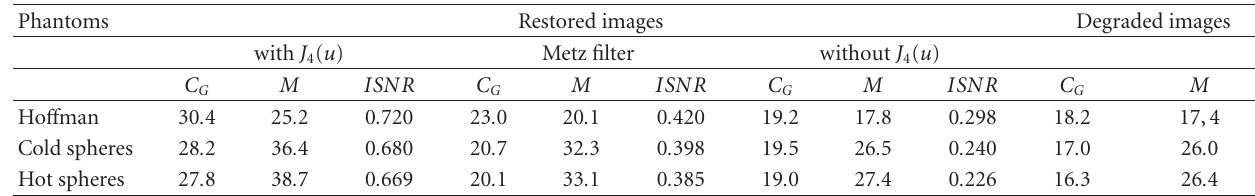
Table 1: The global contrast C G and the mottle M (expressed in %) and the improvement signal-to-noise ratio ISNR (expressed in dB) obtained from, respectively, the restored image with and without J 4 ( u ), the Metz filter, and the degraded images that are the original phantom SPECT. Phantoms Restored images